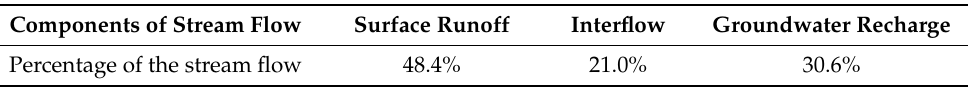
Table 3. Major components in stream flow as the results of rainfall runoff from model simulations between 1 January 2003 and 31 December